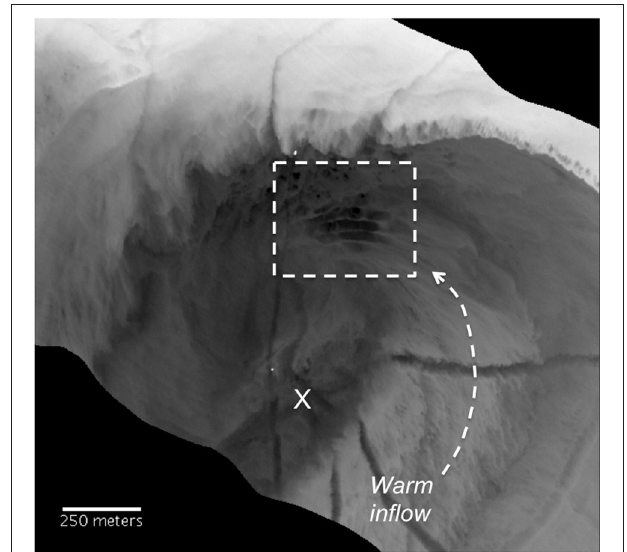
FIGURE 6 | ADCP vs. IR estimates of velocity magnitude (A), vorticity (B) and divergence (C) plotted against radial distance. ADCP-derived values of vorticity and divergence are computed using Equations (1, 2) in the text. Red curves use data from the half of the boat track lying south-east of the vortex center; blue, the half north-west of center (c.f., Figure 5A ); corresponding shading shows variability with depth. Dashed curves show IR-derived radial profiles after azimuthally averaging the results in Figure 4 ; vertical error bars at r = 200m indicate a range of two standard deviations.